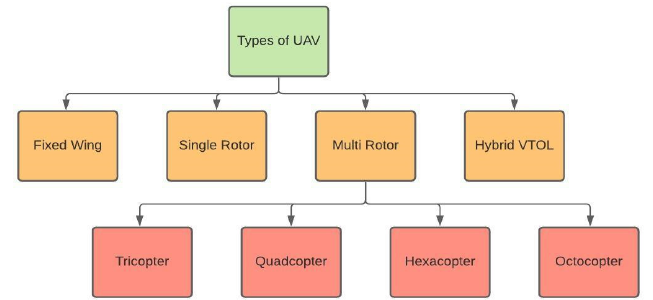
Figure 2. Types of UAV.